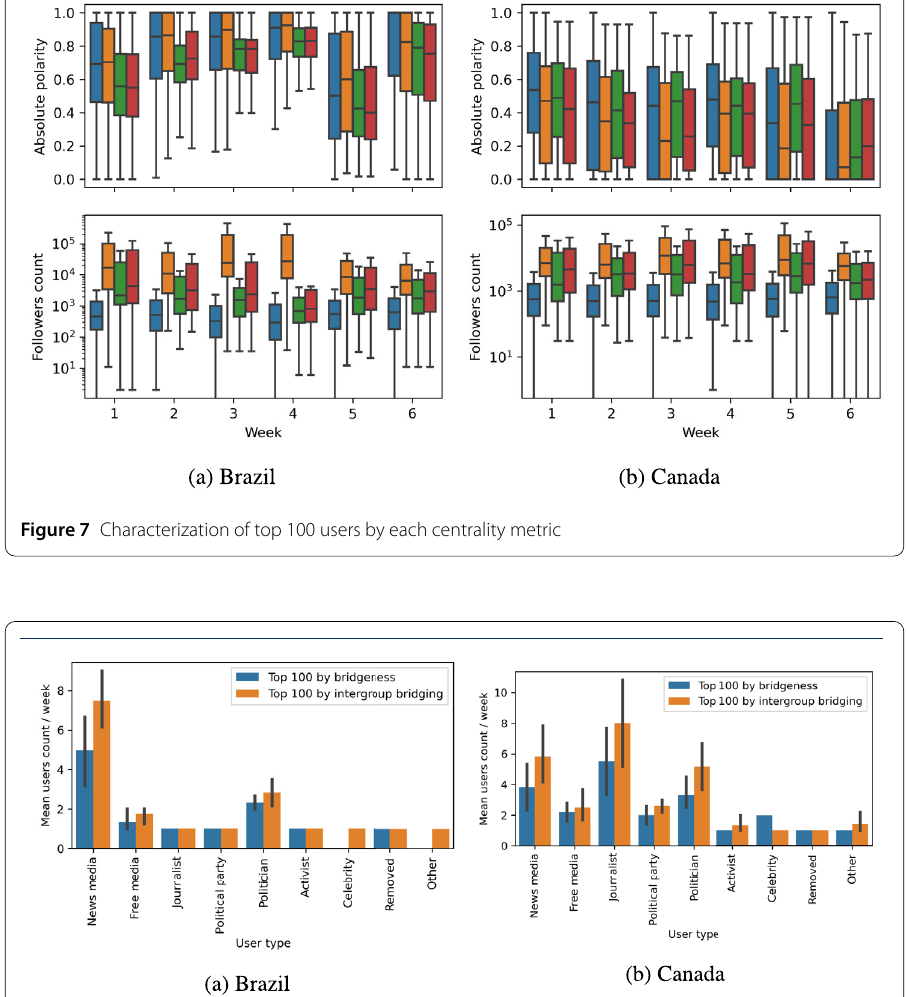
more diverse content. It is worth mentioning that the number of unique hashtags applied according to its political orientation is still virtually the same between highly central bub- ble reachers and all other users. That is, they do not have clear differences in choosing hashtags according to its political